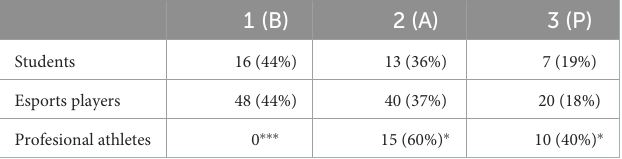
TABLE 1 Enterotype abundance in students, esports players, and professional